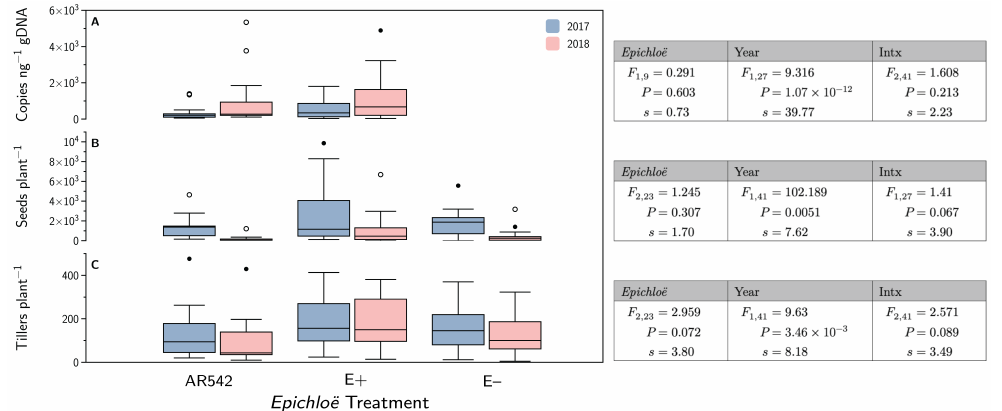
Figure 4. Plant reproduction and Epichloë concentration. Plotted are the untransformed data. ( A ) de- notes the number of copies of TefA gene, used to estimate the concentration of Epichloë endophytes in the host plant, expressed per ng of total genomic DNA. ( B ) shows the number of seeds per plant. ( C ) shows the number of live tillers per plant. The • symbols indicate observations > 1.5 × the inner quartile range, and the ◦ symbols indicate observations that are > 3 × the inner quartile